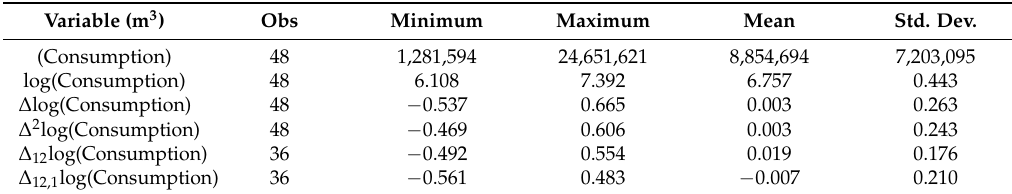
Table 3. Descriptive statistics of monthly consumptions.